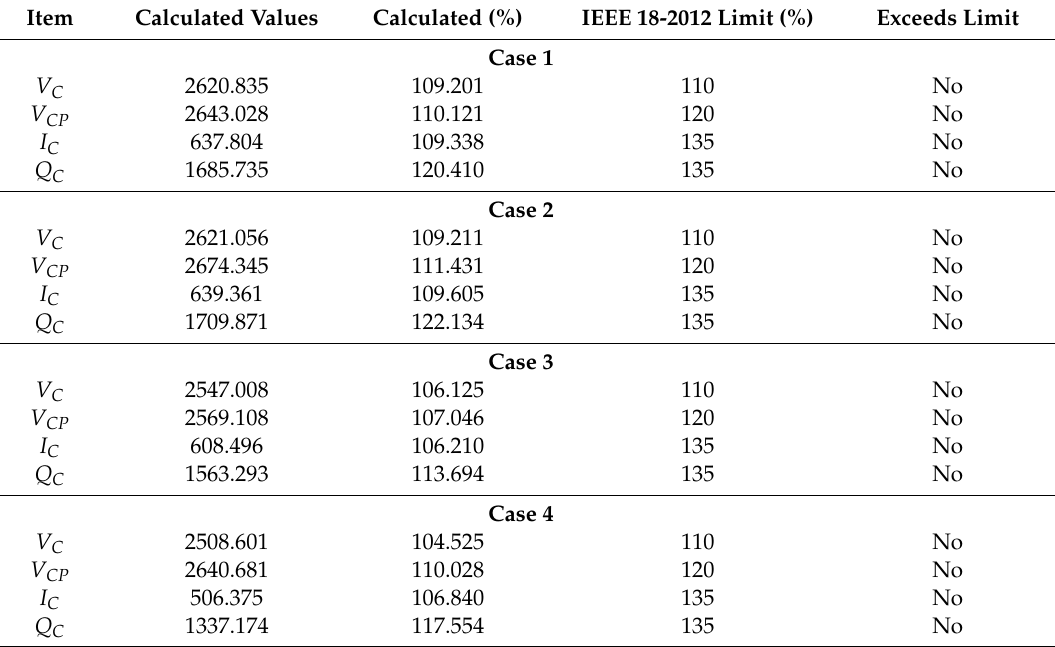
Table 5. Capacitor duties calculation for all case